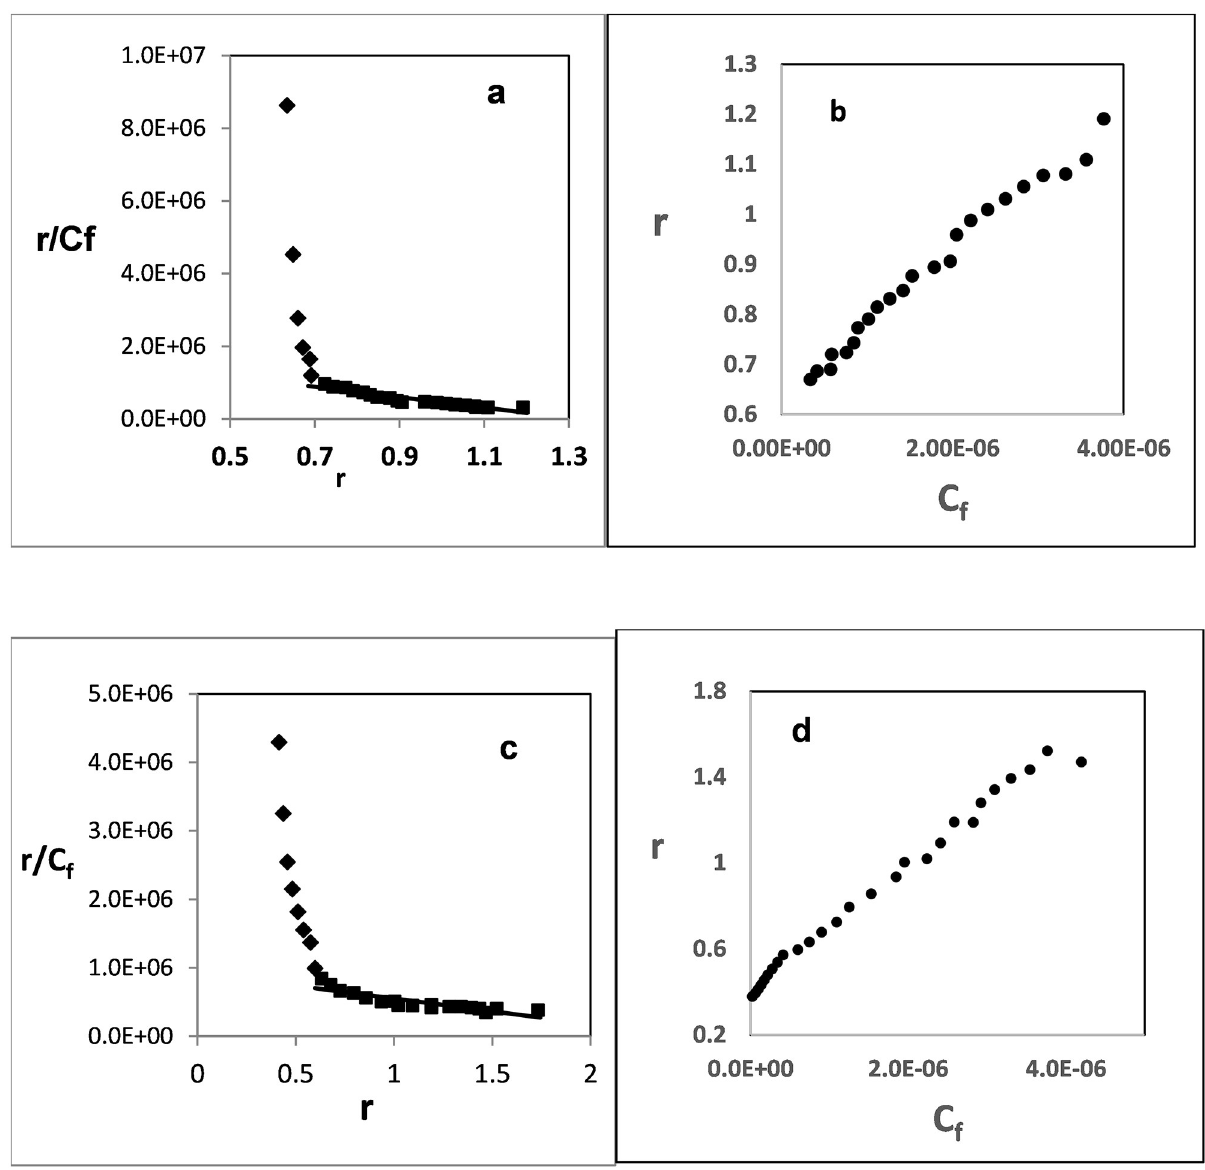
Fig 5. Nonlinear Scatchard plots. Increasing concentrations of human telomeric G-quadruplex DNA (1.44 x 10 − 4 M) were added to 2.0 ml of (5 × 10 − 6 M) GW-2974 ( a , b ) and SCH-442416 ( c , d ). The reaction was followed by measuring fluorescence emission of both compounds in Tris–KCl buffer, pH 7.4.